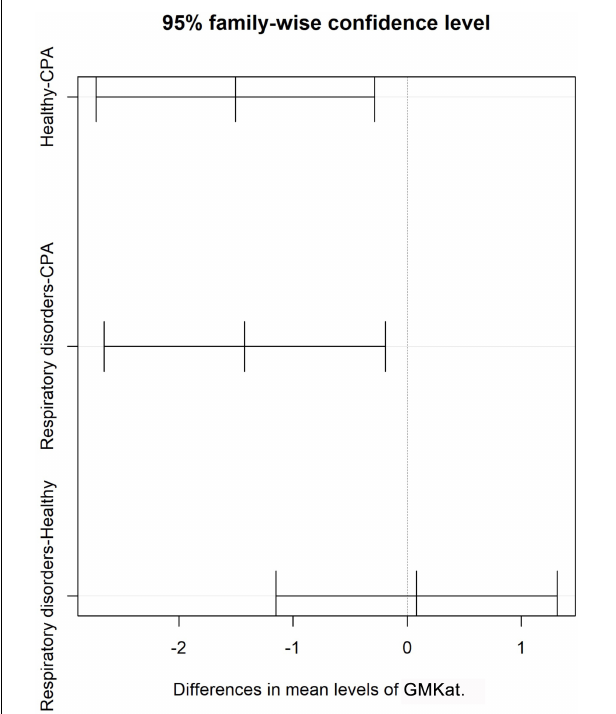
Frontiers in Microbiology |